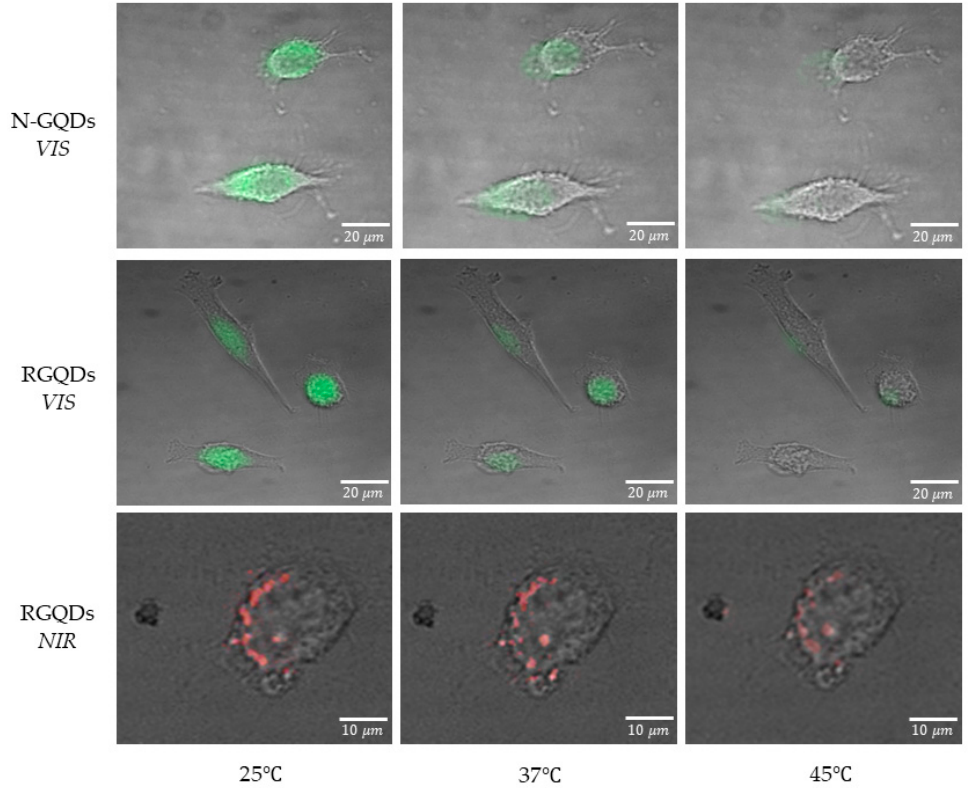
Materials 2021 , 14 , x FOR PEER REVIEW Figure 3. Fluorescence images of N-GQDs and RGQDs internalized into HeLa cells taken at 25, 37 and 45 ° C. In order to quantify this trend, the average fluorescence intensity per unit cell area collected for over 200 cells is calculated and compared at different temperatures for both GQD types in the visible and for RGQDs in NIR. This statistical data (Figure 4) indicates even more drastic fluorescence variations than those observed spectroscopically in the visible for N-GQDs and RGQDs, with N-GQDs showing a greater response. The NIR RGQDs also exhibit the quenching expected from the prior spectral analysis and enabling temperature sensing.